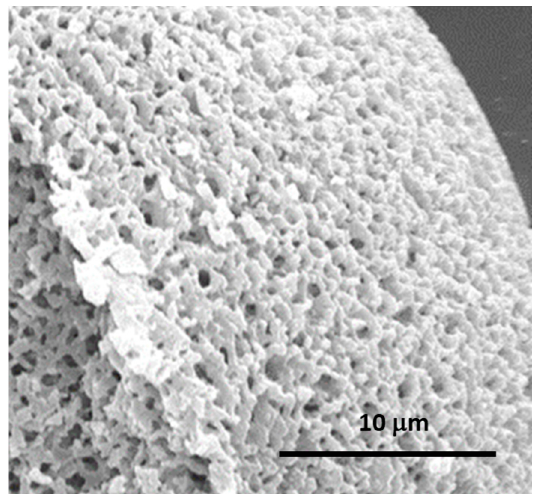
Figure 31. SEM image of a porous microsphere (MICROSCAF) obtained when the onset of gelation is coincident with the onset of phase separation (by spinodal decomposition). (A.C. Marques et al., unpublished results).